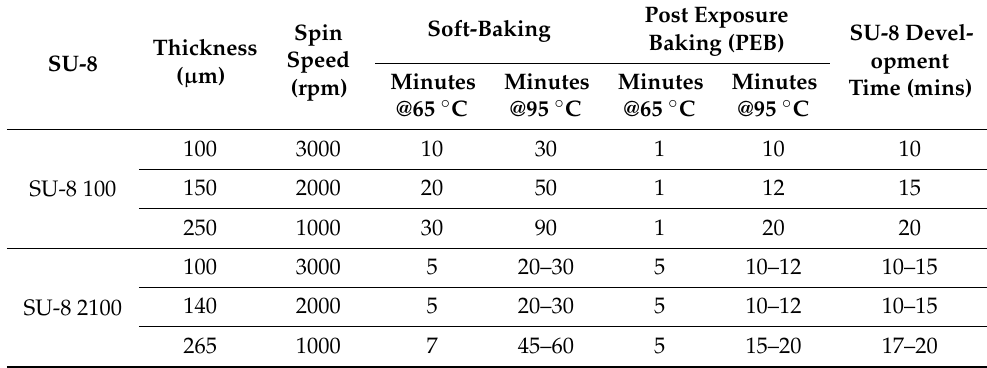
Table 2. Spin speed, soft-baking conditions, post-exposure baking conditions, and SU-8 development time based on the desired thickness of SU-8 100 or SU-8 2100 on a 4” silicon